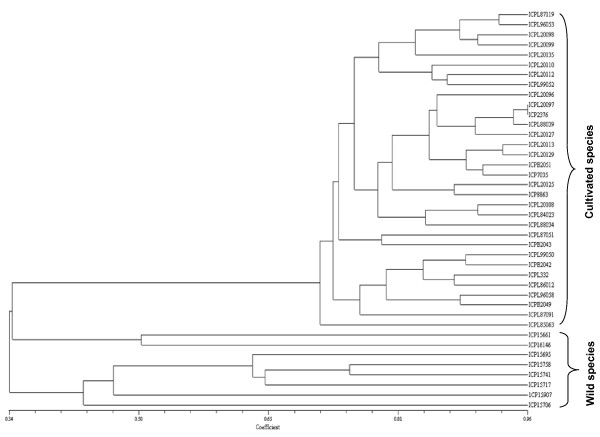
Dendrogram of elite pigeonpea accessions based on UPGMA analysis. Unweighted Pair Group Method using arithmetic average dendrogram showing relatedness among the forty elite pigeonpea genotypes representing 8 wild species and 32 cultivated genotypes. The scale at the bottom of the dendrogram indicates the level of similarity between the genotypes.